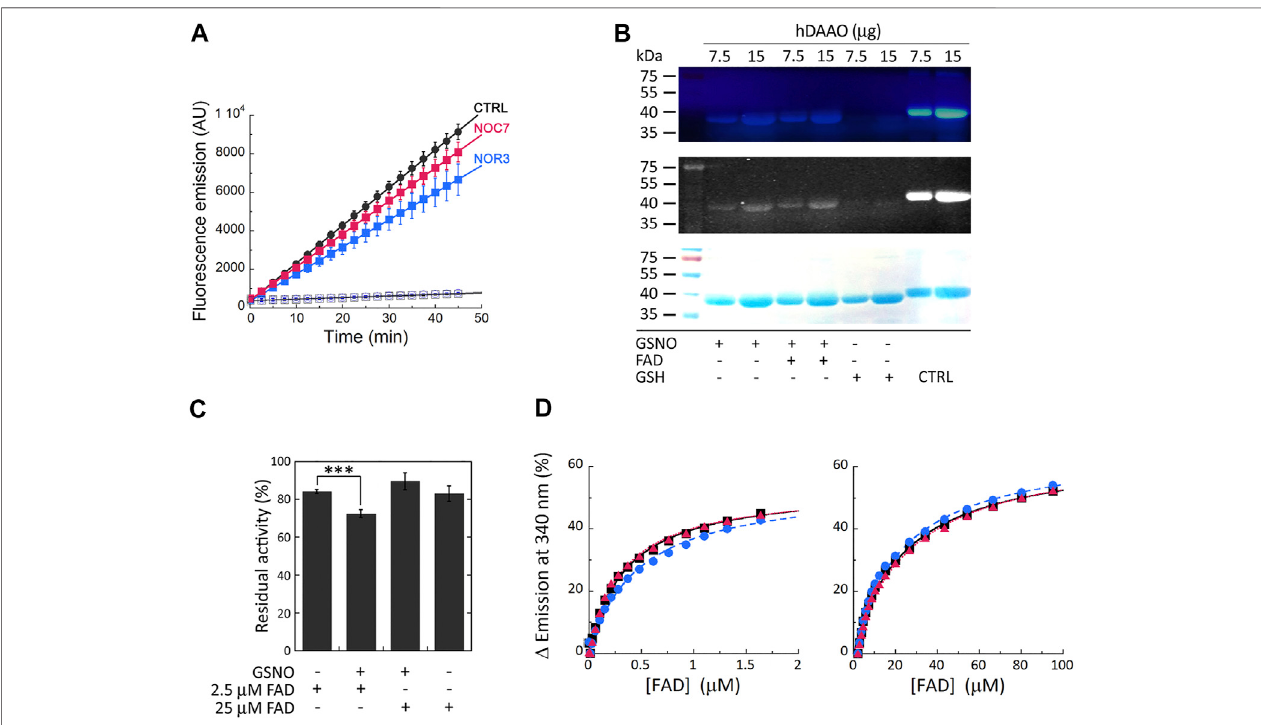
FIGURE 2 | S-Nitrosylation of hDAAO induces partial inactivation. (A) The treatment of U87 cells ectopically expressing hDAAO with the NO donors NOR3 and NOC7 reduced the activity of the fl avoenzyme. hDAAO-expressing cells were treated with 50 µM NOC7 (red squares), 50 µM NOR3 (blue squares), or with an equal